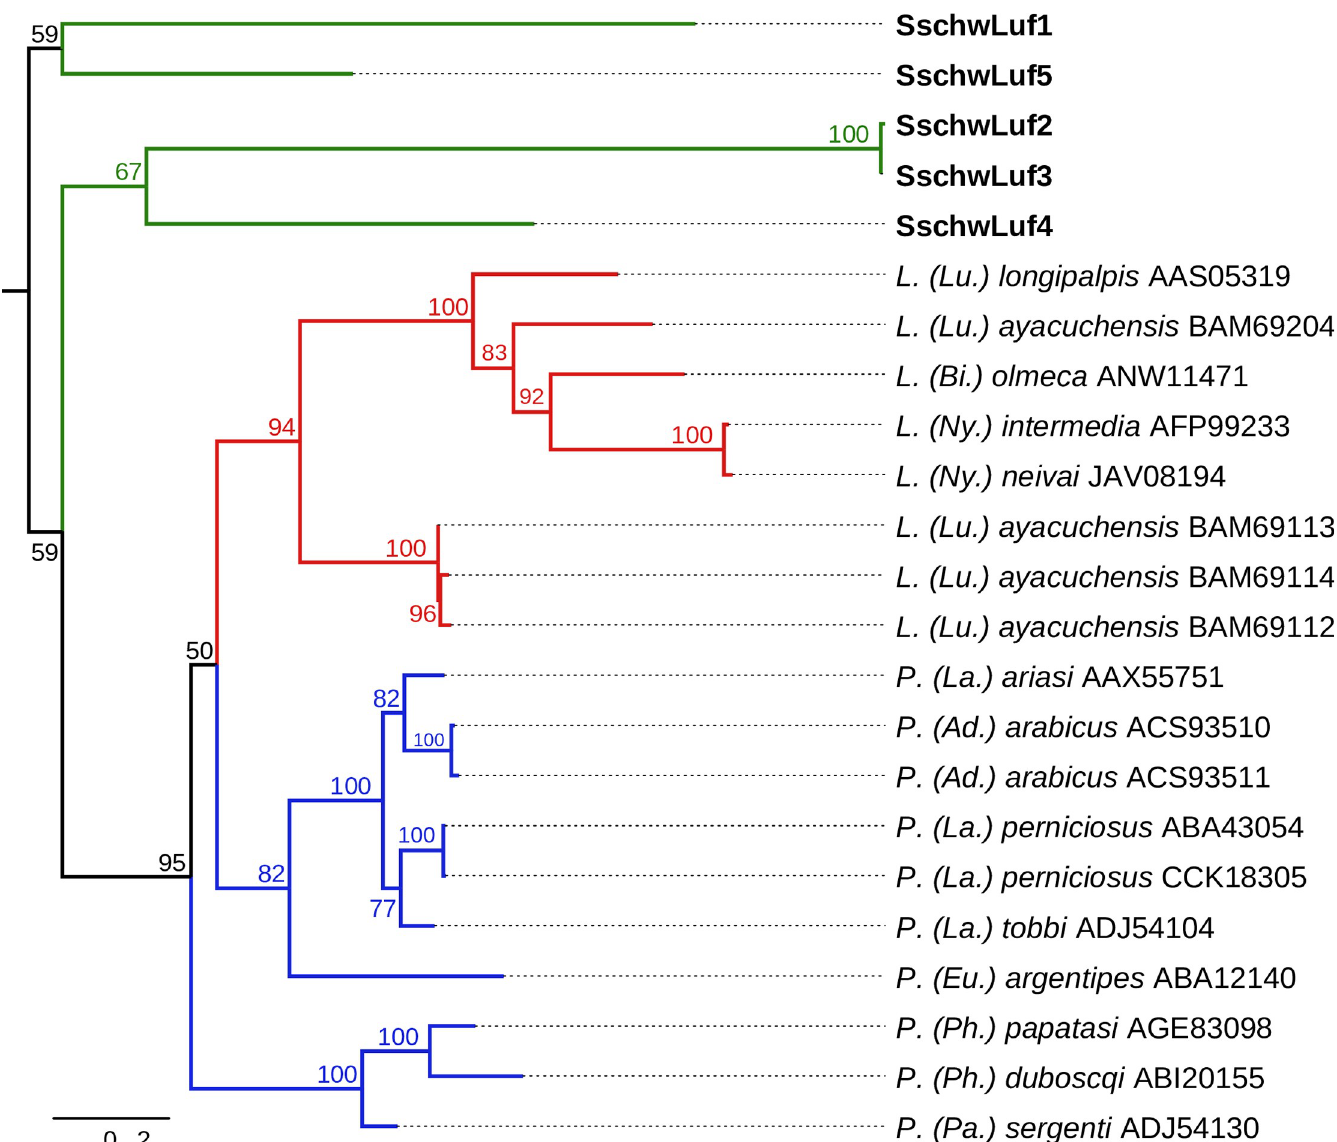
Fig 2. Phylogenetic comparison of antigen 5-related proteins. The phylogenetic tree with 20 sequences was based on MAFFT alignment with BMGE (threshold 0.4) containing 240 aa sites, 124 parsimony-informative sites, 49 singleton sites and 67 constant sites. The node values represent the percentage of bootstrap support for each branch (values equal or higher than 50% are shown). The position of sand flies of Lutzomyia genus is marked by red branches color, the sand flies of Phlebotomus genus are marked with blue branches color. The S . schwetzi proteins are marked by green branches color. For rooting the tree, the Aedes aegypti (XP_021712908) sequence was used (branch in black). The sand flies’ subgenera are marked by shortcut in parentheses: Ad . - Adlerius , La . - Larroussius , Eu . - Euphlebotomus , Ph . - Phlebotomus , Pa .– Paraphlebotomus , Lu . - Lutzomyia , Bi . - Bichromomyia , Ny . - Nyssomyia .